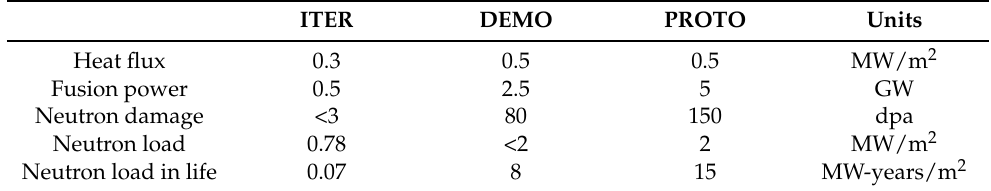
Table 1. Loads suffered by the PFCs in the FW. Adapted from Ref.